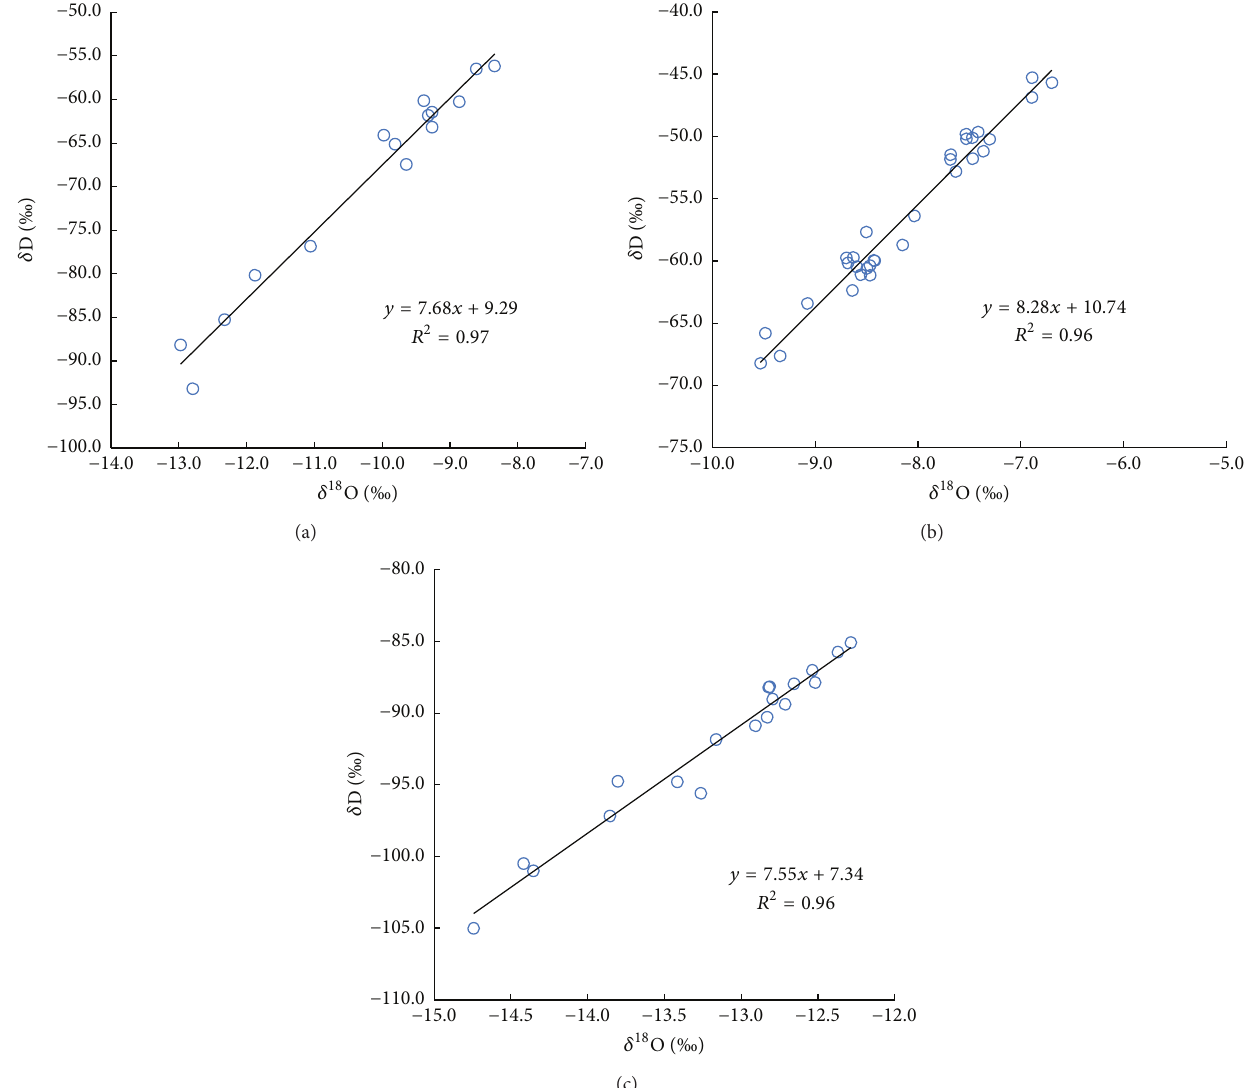
Figure 5: Stable isotope ( 𝛿 D and 𝛿 18 O) compositions of precipitation (a), groundwater (b), and glacial meltwater (c).